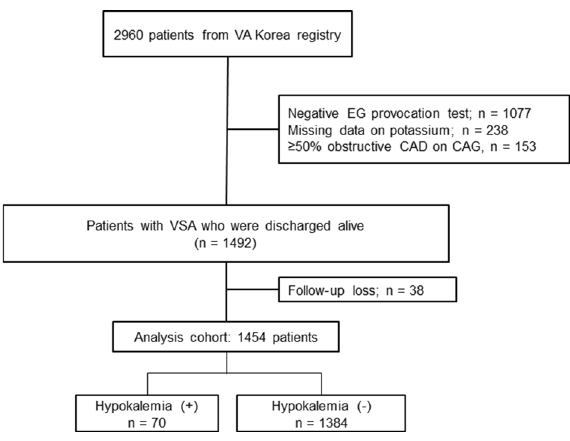
Figure 1. Study flow. VA variant angina, EG ergonovine, VSA vasospastic